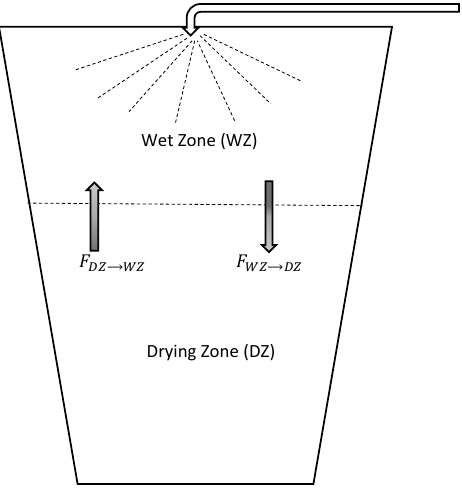
Figure 2. Schematic representation of the two-compartment